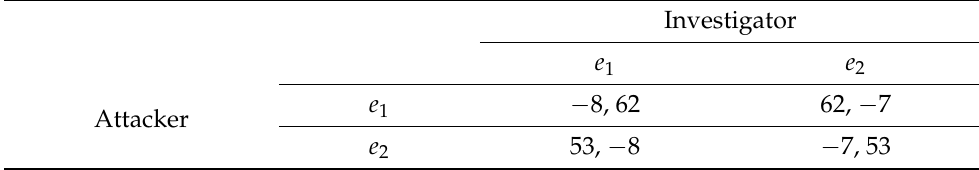
Table 2. Payoffs for example